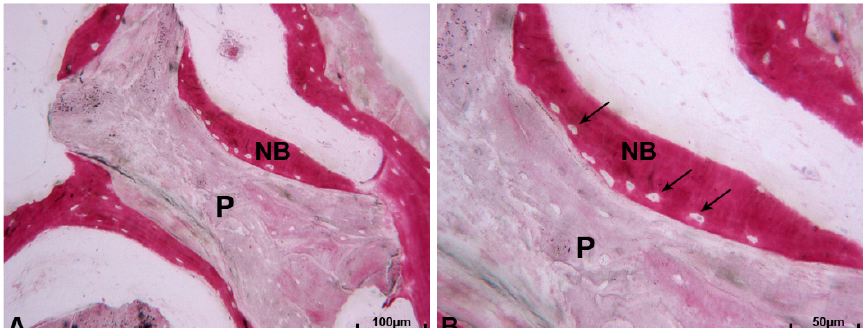
Figure 2. DEBM. ( A ) The residual DEBM particles (P) were encircled by newly formed bone (NB), which was characterized by extensive osteocyte lacunae, and no gaps were evident at the bone biomaterial interface. Toluidine blue and acid fuchsin, original magnification 100 × . ( B ) At higher magnification, many osteocyte lacunae (black arrows) at the biomaterial–particle interface (P) were present. Toluidine blue and acid fuchsin, original magnification 200 × .